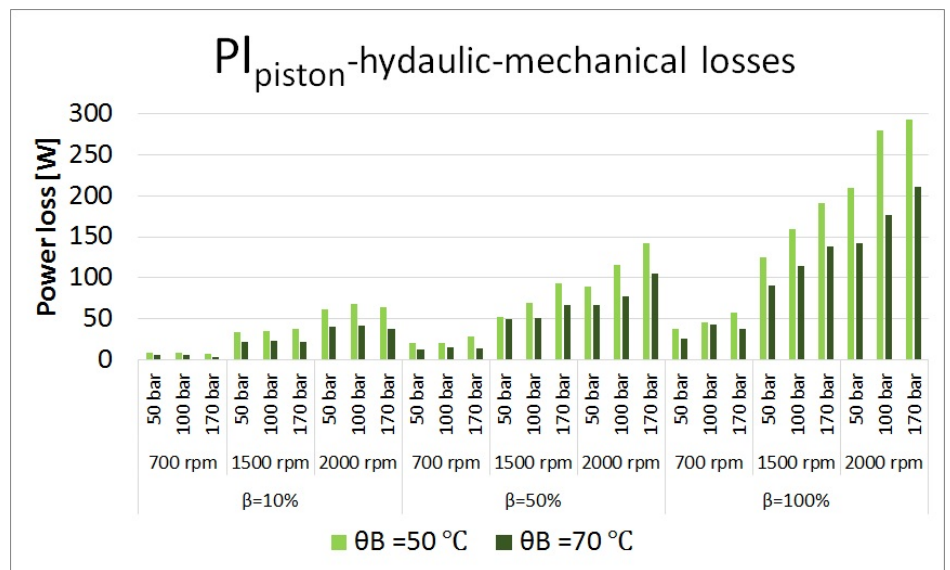
Figure 26. Hydraulic-mechanical losses in piston/cylinder bore interfaces at different operating conditions.